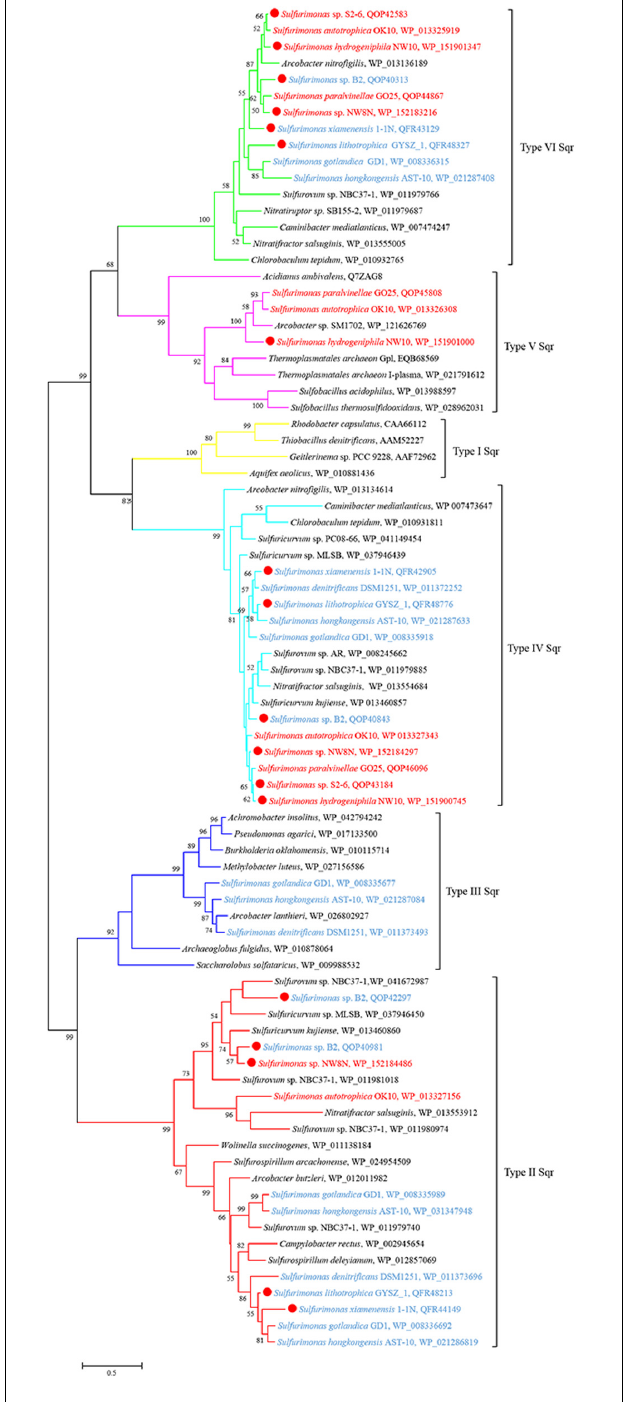
FIGURE 5 | Maximum likelihood phylogenetic tree of Sqr protein sequences derived from Sulfurimonas strains and other representative species within the class Campylobacteria . Bootstrap values indicated at each node are based on a total of 1,000 bootstrap replicates. Branch node values below 50% are not shown. The solid red circles represent our own isolated strains. Branches representing different type of Sqr are different color. Isolation sources of Sulfurimonas species are indicated in different font colors: red, hydrothermal environments; blue, marine non-vent